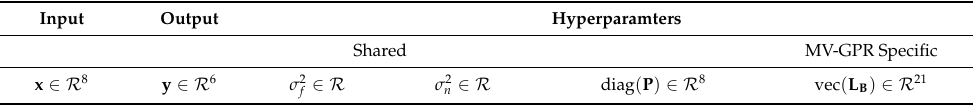
Table 2. GPR parameters and their dimesnions in the IOD